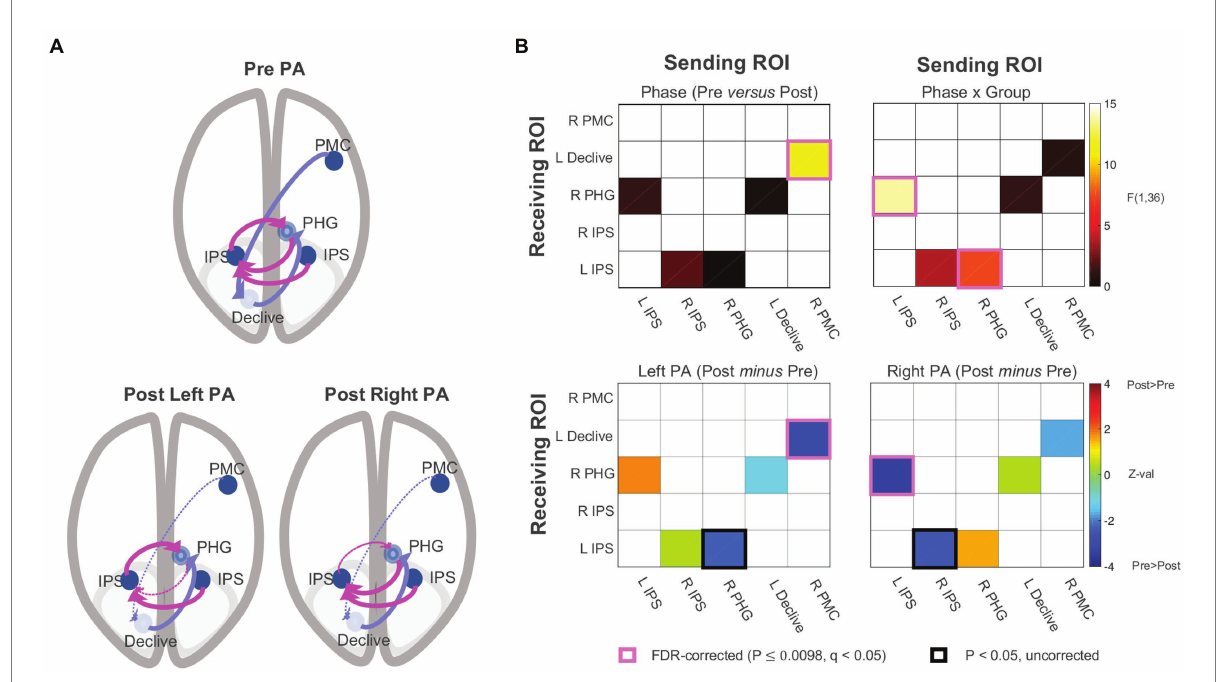
FIGURE 5 Effective connectivity results. (A) Five-parameter model identified by statistical equation modeling (top) and changes post PA relative to pre PA after left and right PA (bottom panels). Dotted line = Decrease in effective connectivity related to the significant main effect of Phase and Phase X Group interactions shown in (B) . Effective connectivity correlation matrices. PA, prism adaptation. IPS, intraparietal sulcus; PHG, parahippocampal gyrus; PMC, premotor cortex. See also Supplementary material.